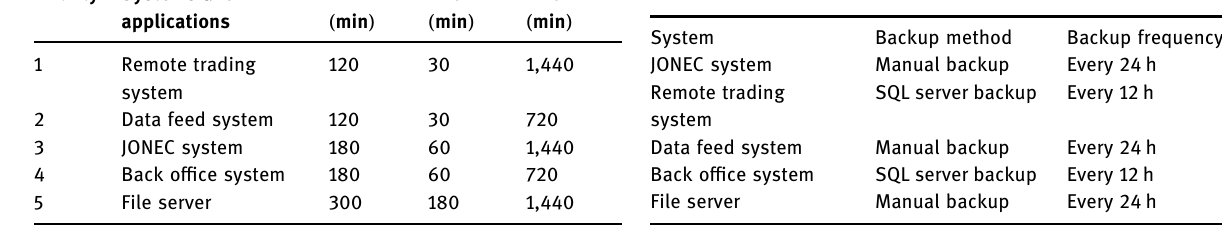
Table 6: System recovery priority Priority Systems and